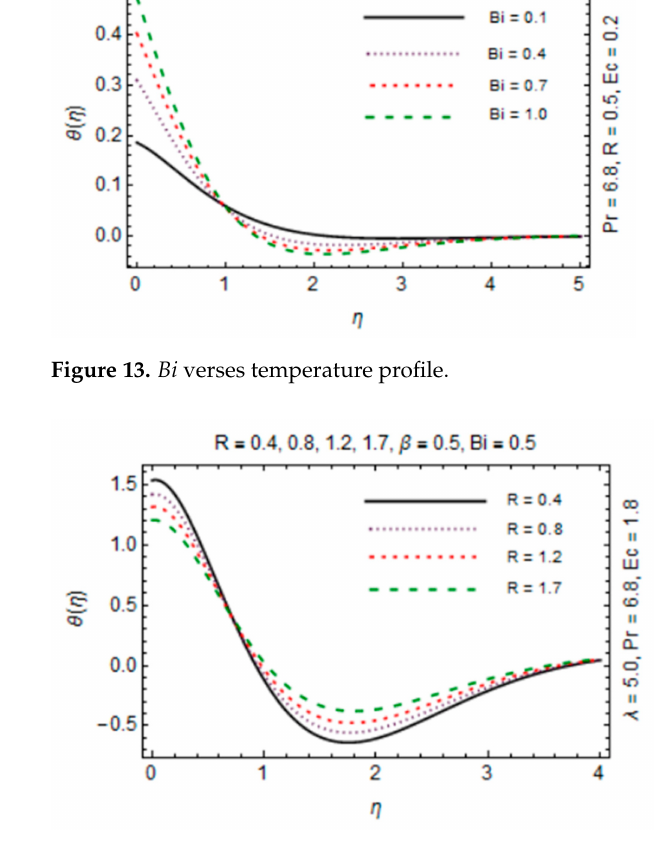
Figure 14. R verses temperature